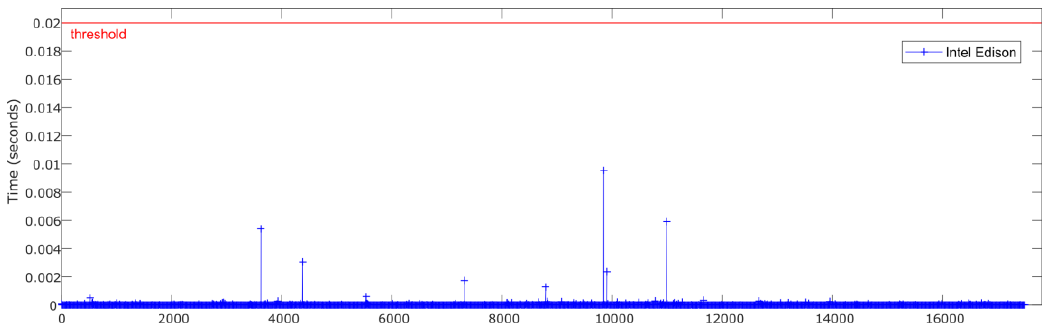
Figure 15. Test 3. Processing time of each iteration for Intel Edison.